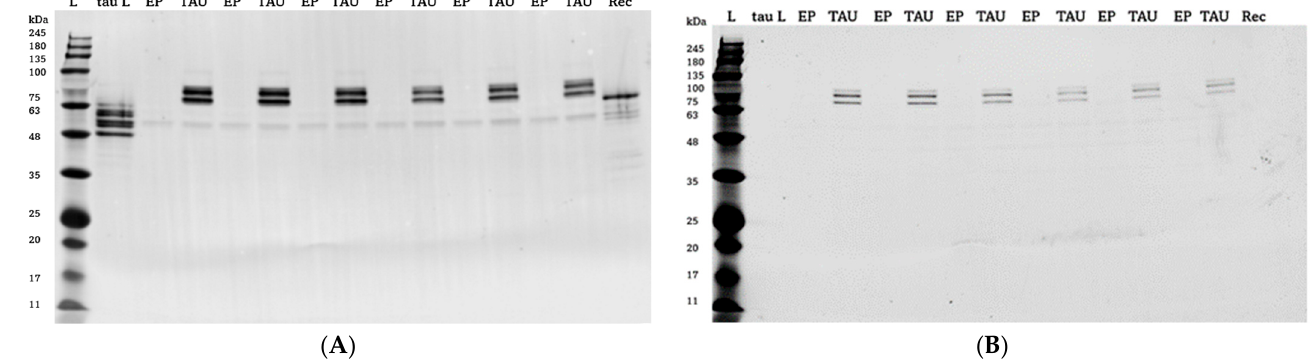
(TAU) cells than in cells transfected with the empty plasmid (EP cells) (Figure 2).